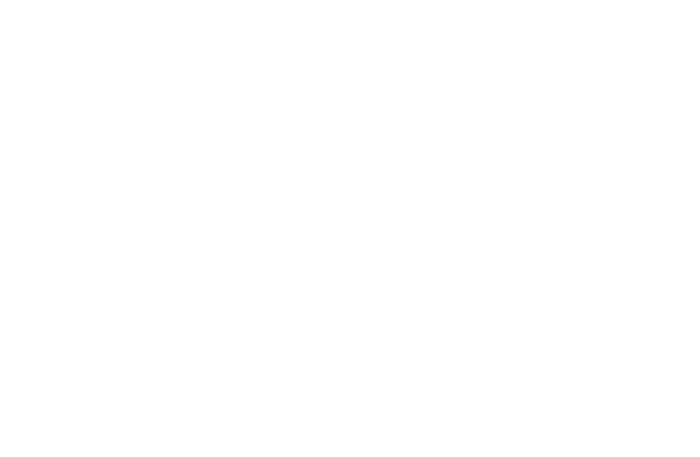
Figure 1. A typical corrugated plate of commercially produced GPHE: 1—ports for streams entrances and exits; 2, 5—zones for flow distribution; 3—gasket; 4—the major heat transfer field.